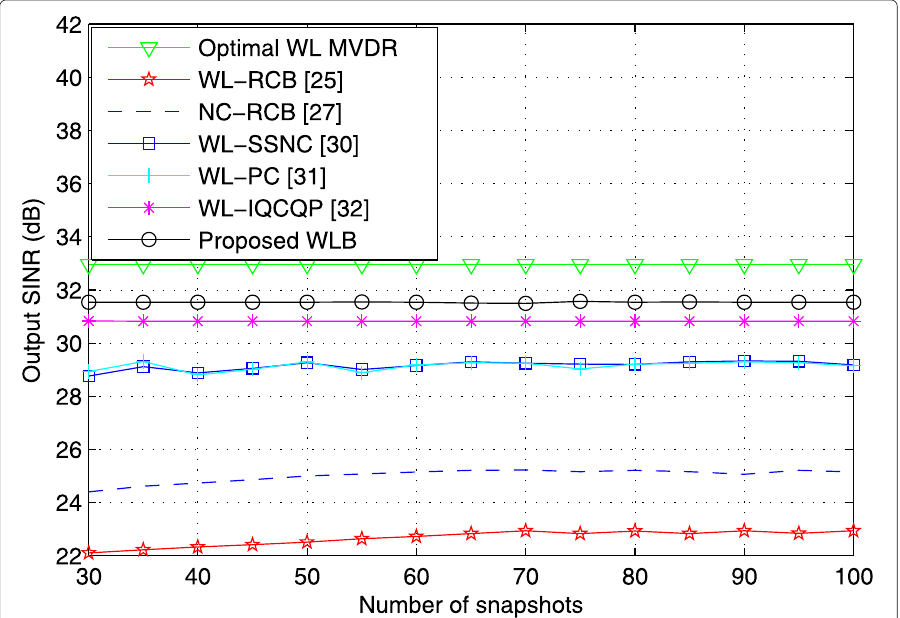
Fig. 5 Example 2. Output SINR of all WLBs versus the number of snapshots